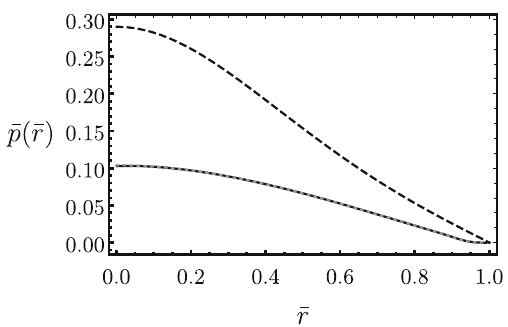
Fig. 15 Pressure as a function of ¯ r in RG, for the constant density case (uppercurve),andfortheexponentialprofile(dashedlowercurve),with ¯ ρ = 0 . 10. The curve in grey was obtained by the integration of the 0 Palatini equations with ¯ λ = 10 − 14